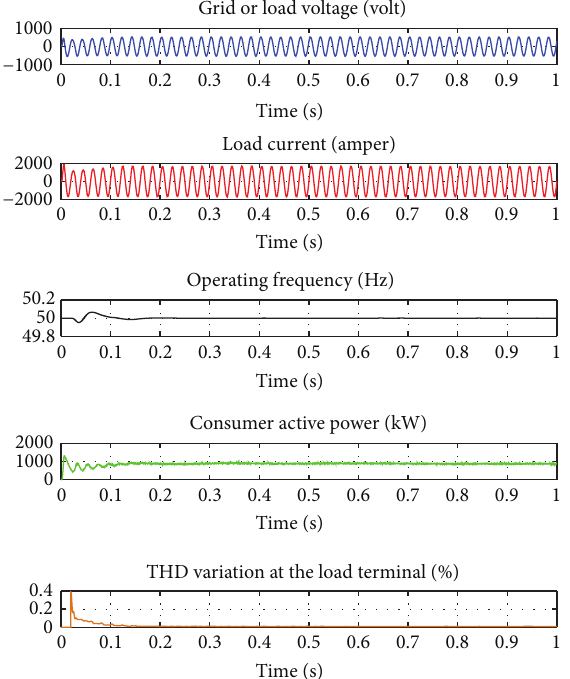
Figure 12: Cases of PMGS based VSWECS containing IGBT-PWM feeds 800 kW consumer power in 4 Khz switching frequency, vari- ation curves of terminal voltage, load current, operation frequency, consumer power and